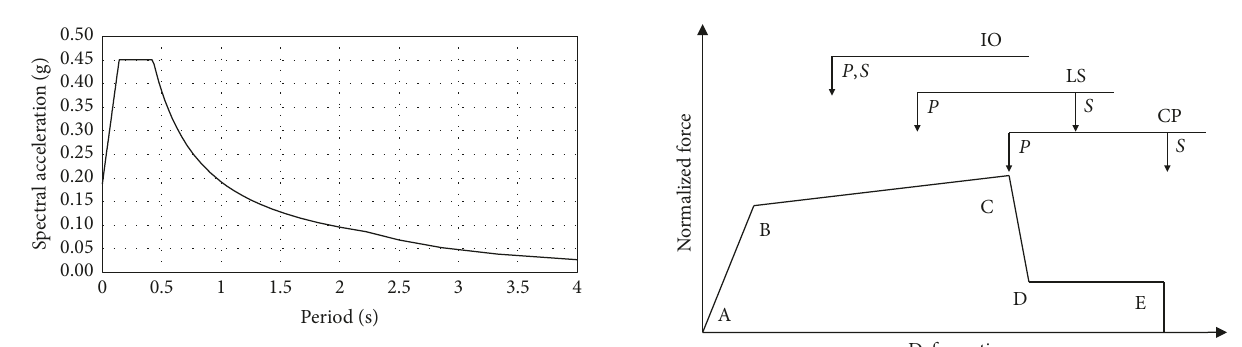
Figure 4: Elastic response spectrum.